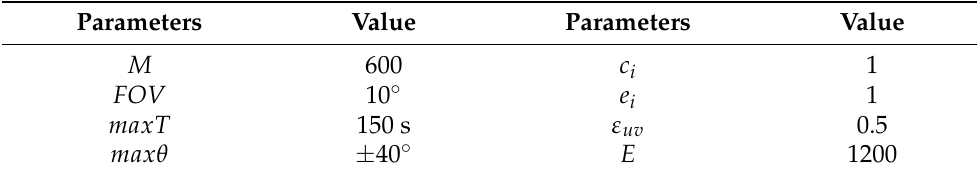
Table 3. Constraint conditions in the task